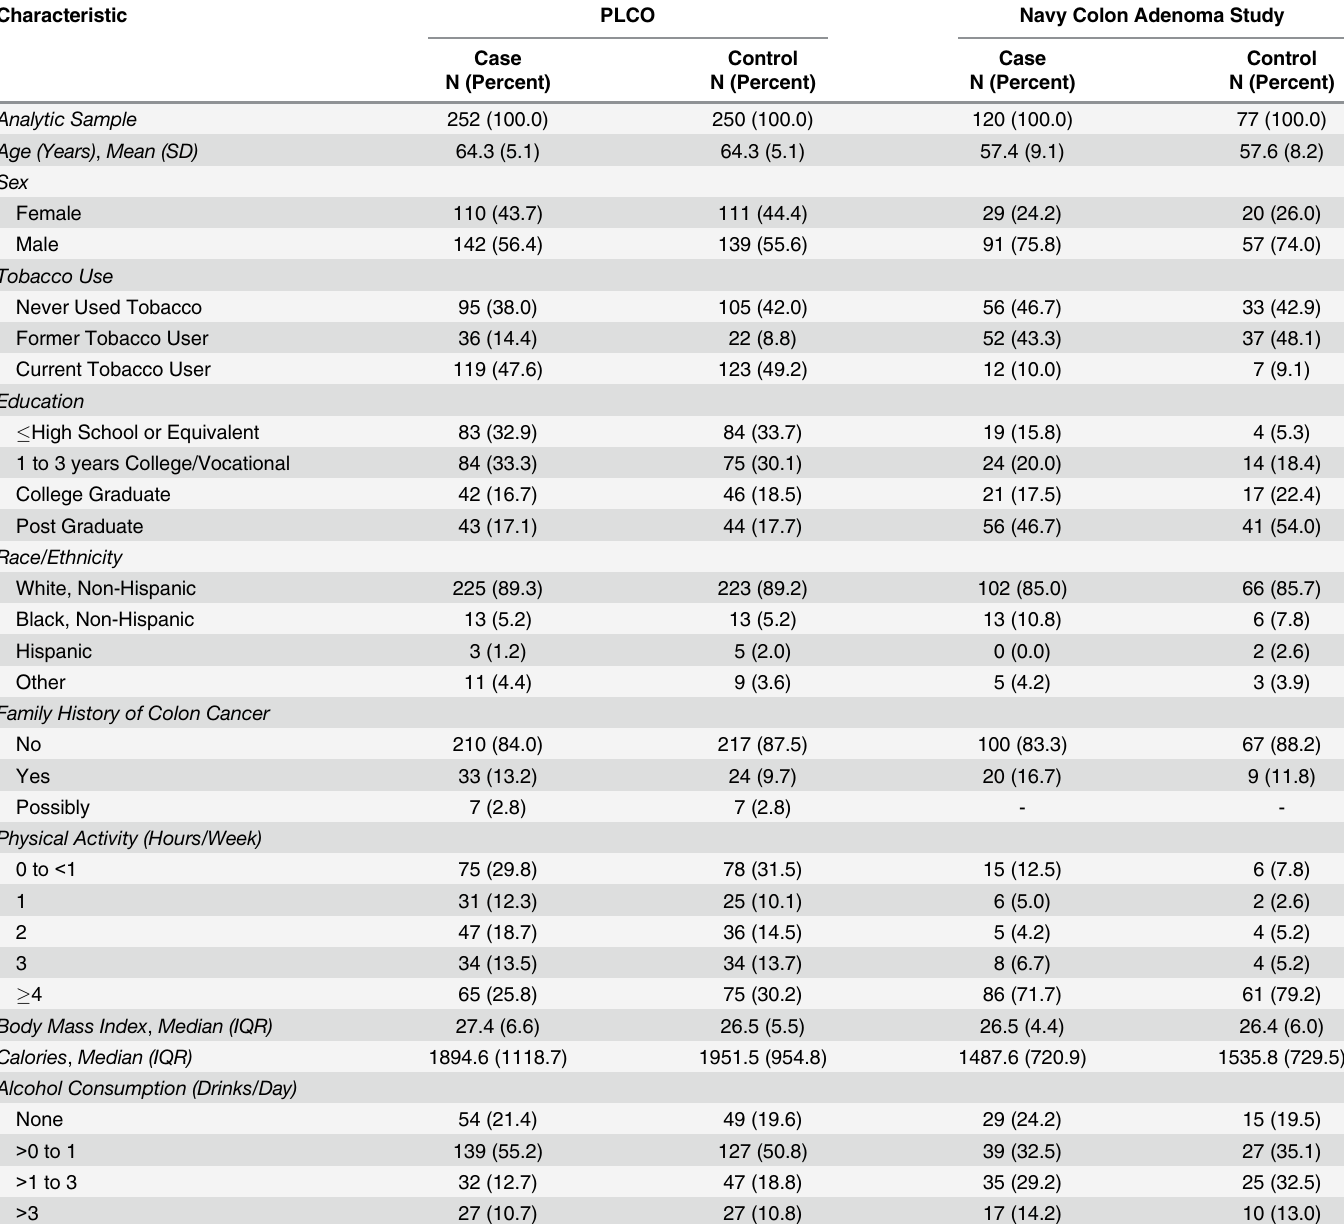
Table 1. Selected Characteristics in 502 US Adults in the Prostate, Lung, Colorectal, and Ovarian Cancer Screening Trial (PLCO) and 197 US Adults in the Navy Colon Adenoma Study.